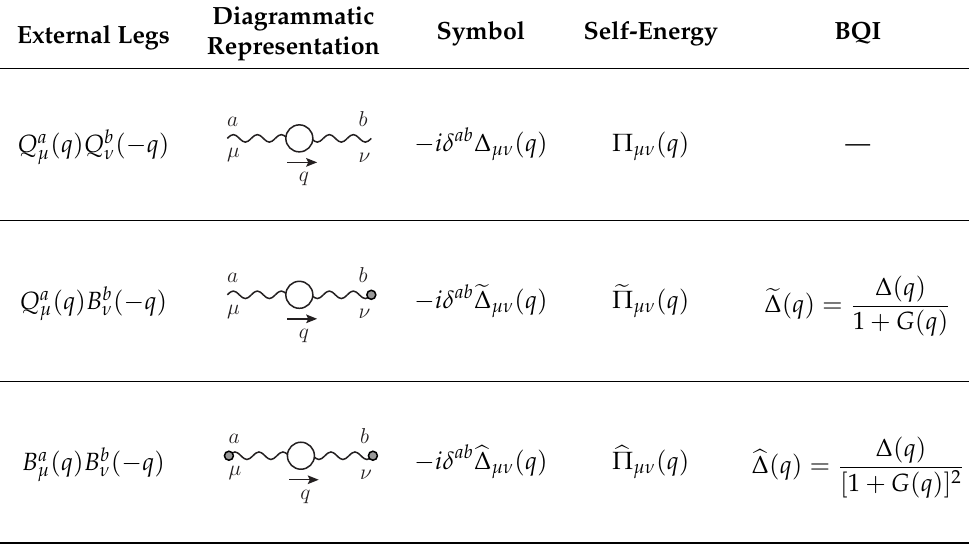
Table 1. The different types of gluon propagators of the background field method (BFM), together with their diagrammatic representations, symbols, corresponding self-energies, and the background quantum identities (BQIs) that relate them to the conventional